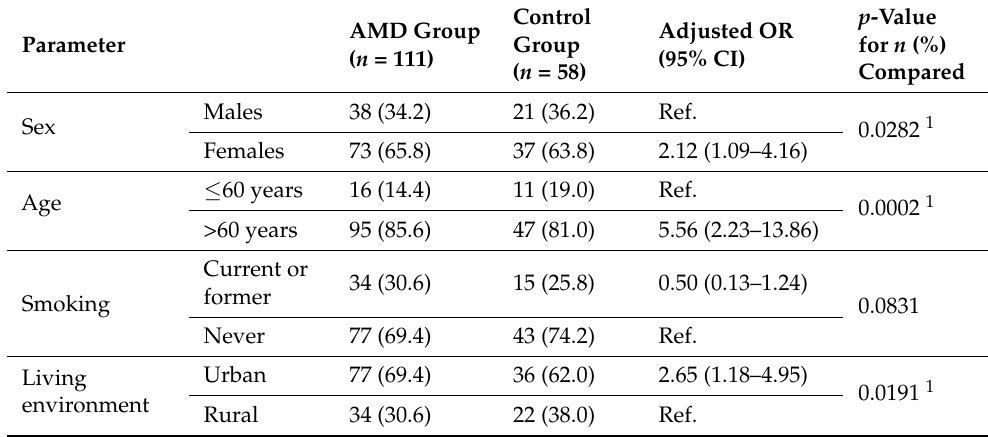
Table 2. Risk of age-related macular degeneration (AMD) associated with sex, age, smoking, living Environment, and family history of